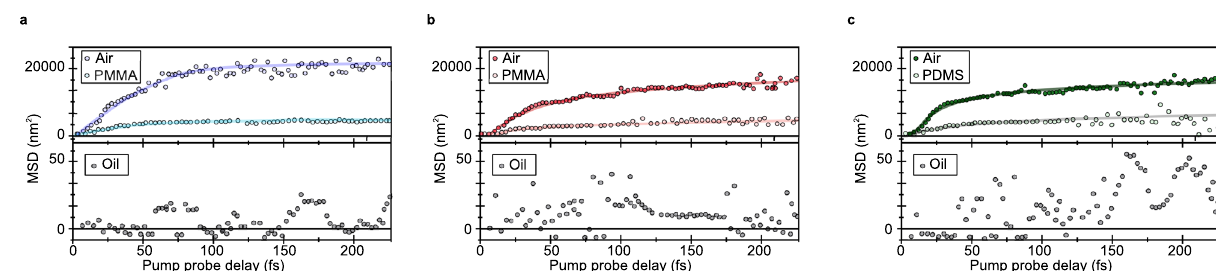
Fig. 5 Tuning energy propagation in organic nanostructures by refractive index engineering of the external environment. a – c Mean square displacement of PDA, PDI and PIC samples (static refractive index ~1.55 – 1.65 79,80 ) with an air gap (dark blue, red or green), polymer (light blue, red or green) and oil (black) atop of the sample. The polymer PMMA or PDMS has a refractive index ~1.4 and oil a refractive index of ~1.55; the choice of polymer is guided by sample preparation requirements (see Supplementary Note 14). As the refractive index of the sample and external environment become matched, ultrafast, ultralong transport akin to that observed in Fig. 3 disappears. Solid lines (top panel) are guides to